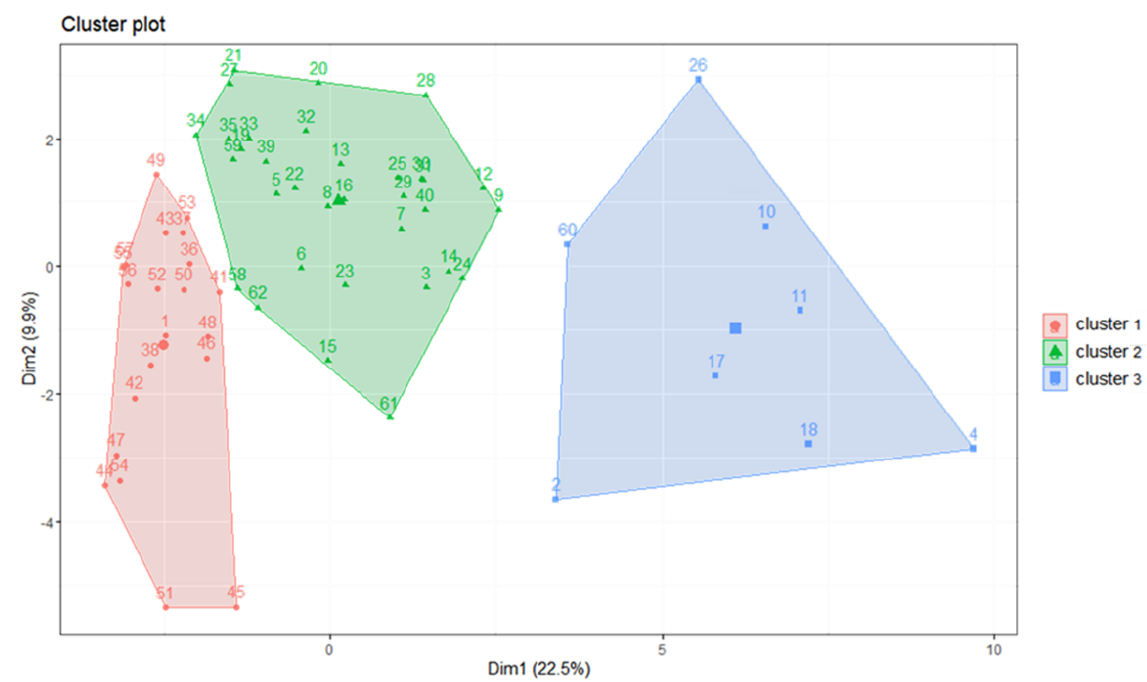
Figure 6. Cluster plot of fish larvae and juveniles collected around Taiwan from 2007 to 2019.